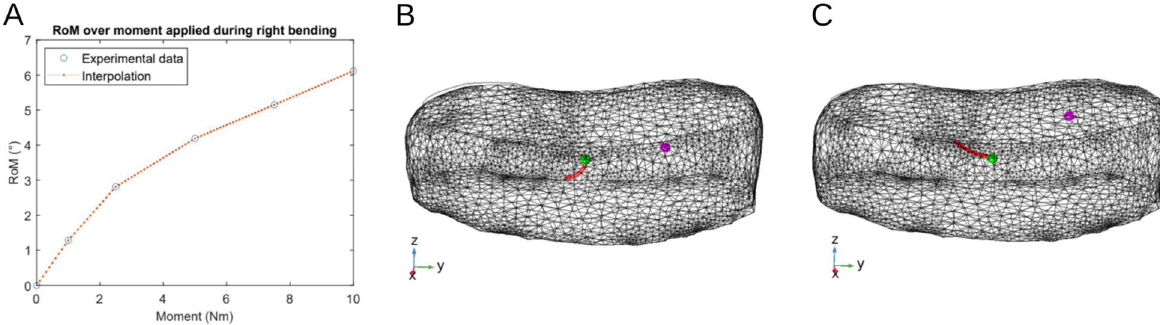
Figure 2. ( A ) Range of motion (RoM) over moment applied in the frontal plane for a L4/L5 human disc during lateral bending. Experimental values taken from Heuer et al. 13 . ( B ) Positions and trajectories of the 3 ICR definitions during LB. Green: hypothesis LB-1. Magenta: hypothesis LB-2. Red: hypothesis LB-3. ( C ) Positions and trajectories of the 3 ICR definitions during AR. Green: hypothesis AR-1. Magenta: hypothesis AR-2. Red: hypothesis